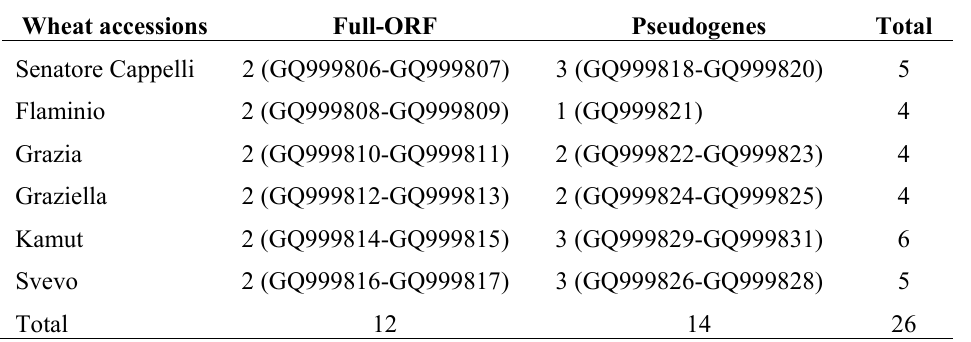
Table 1. Number of obtained unique full Open Reading Frame (ORF) and sequences with one or more stop codons (pseudogenes) from wheats under study. GenBank accession numbers are reported between